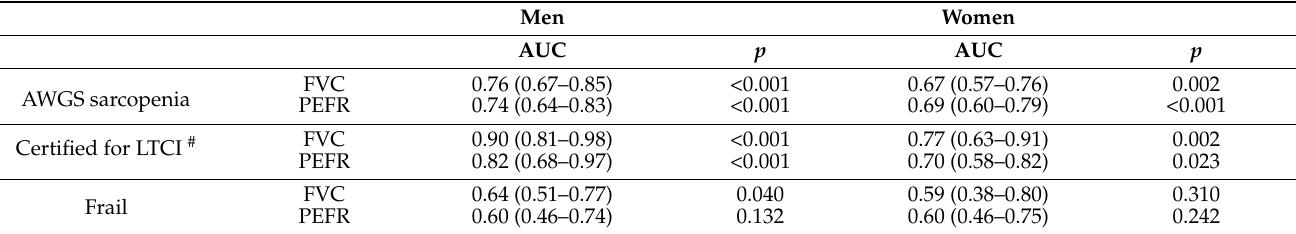
Table 3. ROC analysis of FVC and PEFR for criterion variables.